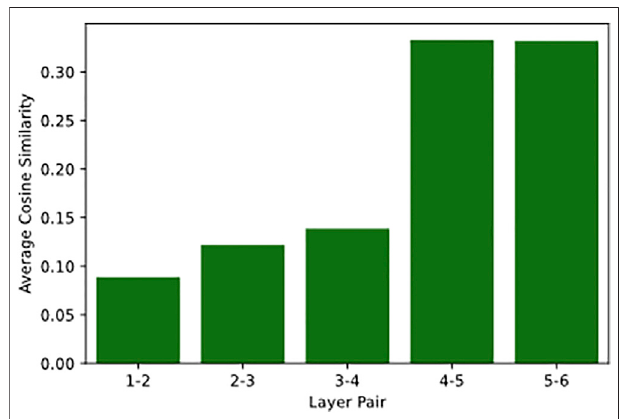
FIGURE 9 | The average cosine similarity between attention weights in neighbouring layers. The horizontal axis shows the speci fi c pair of layers that